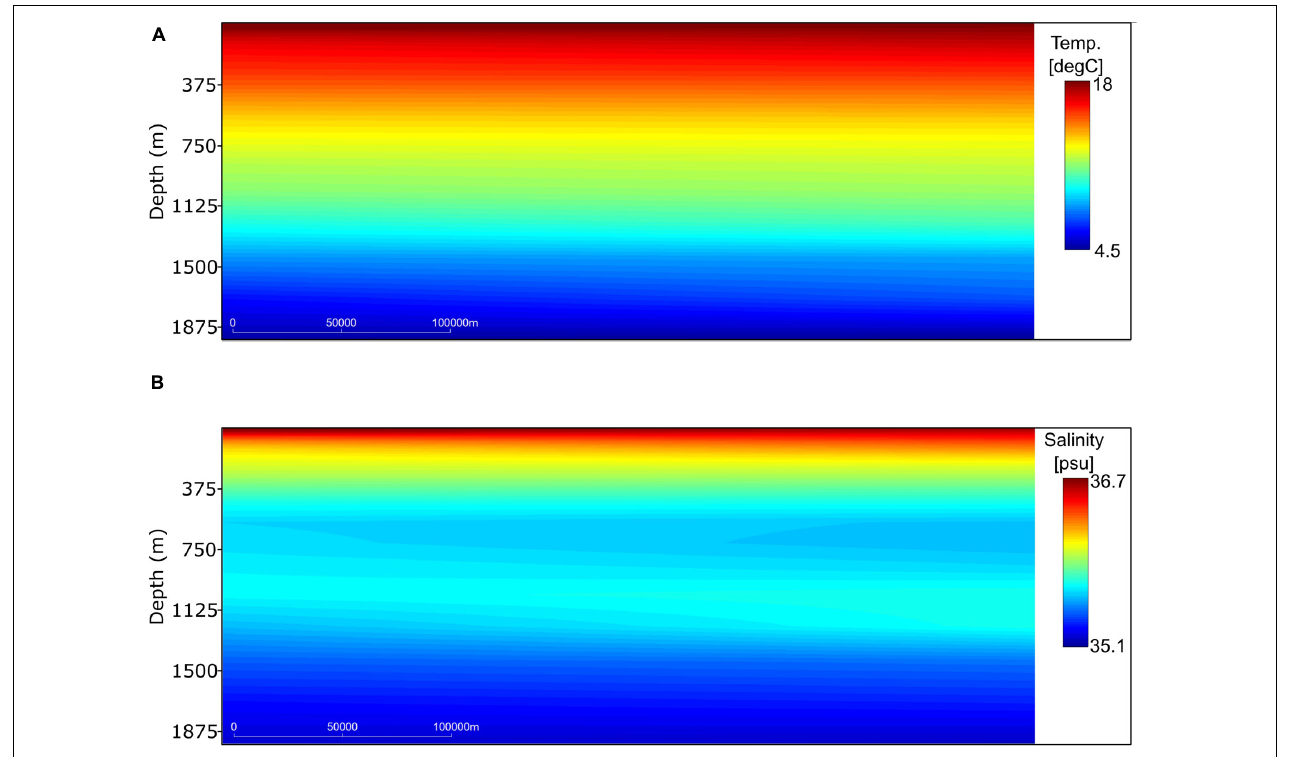
FIGURE 6 | Background models of (A) temperature and (B) salinity extracted from the large-scale dynamics ocean model.